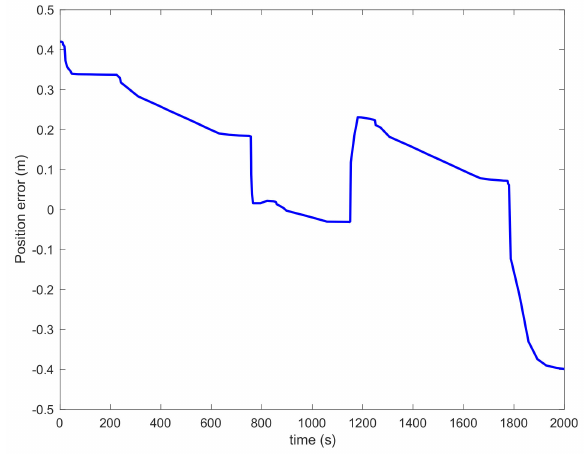
Figure 11. Position error of ATSM-FTC.